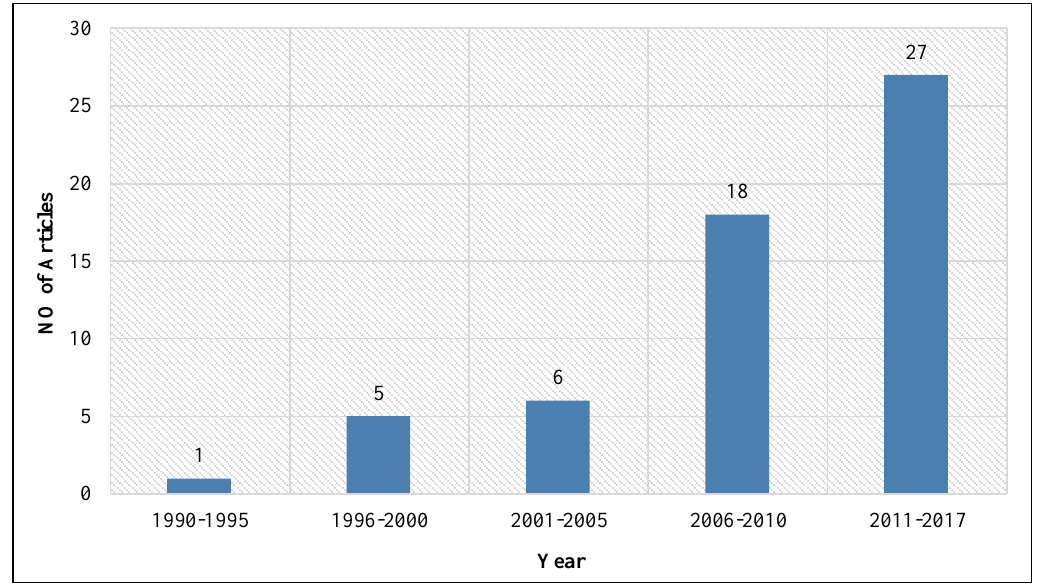
Figure 2. No of Articles on Poor Communication in Construction Industry.